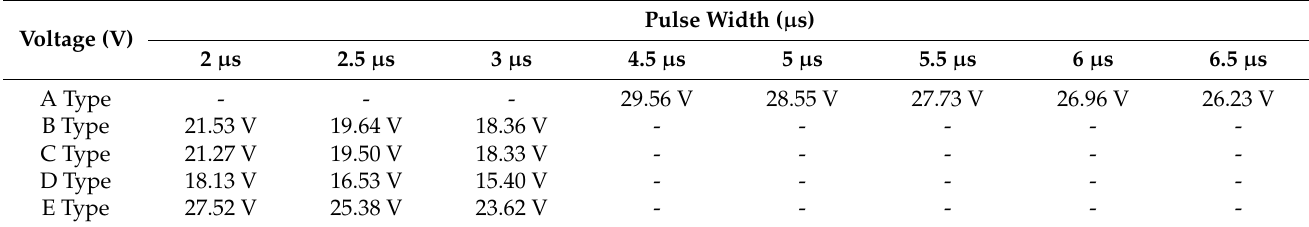
Table 2. Open pool test starting voltage results.